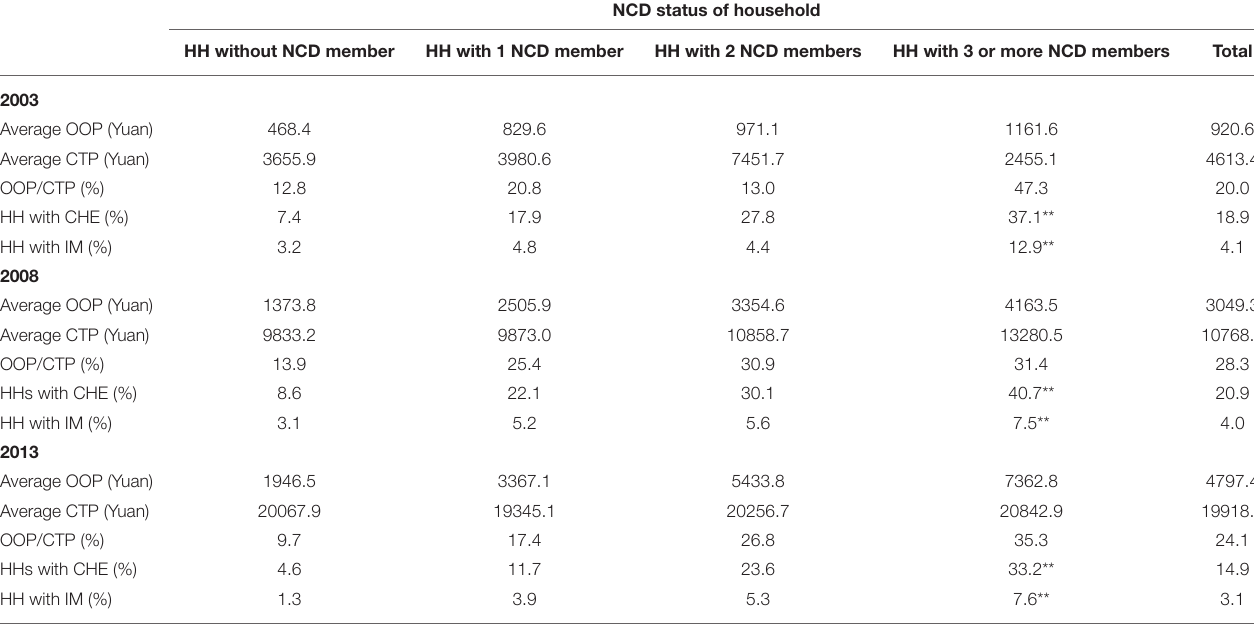
TABLE 2 | Catastrophic health expenditure distribution in NCD